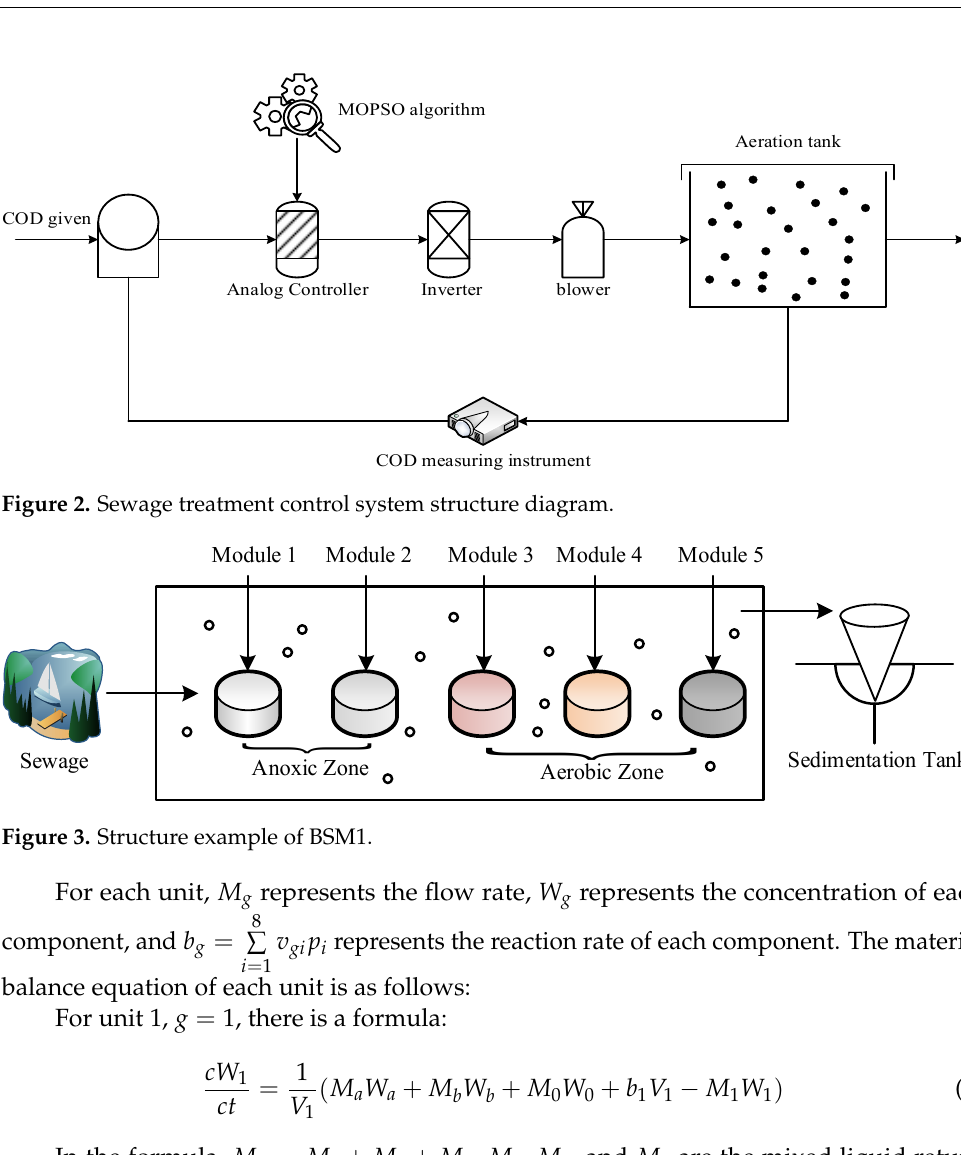
Figure 3. Structure example of BSM1.